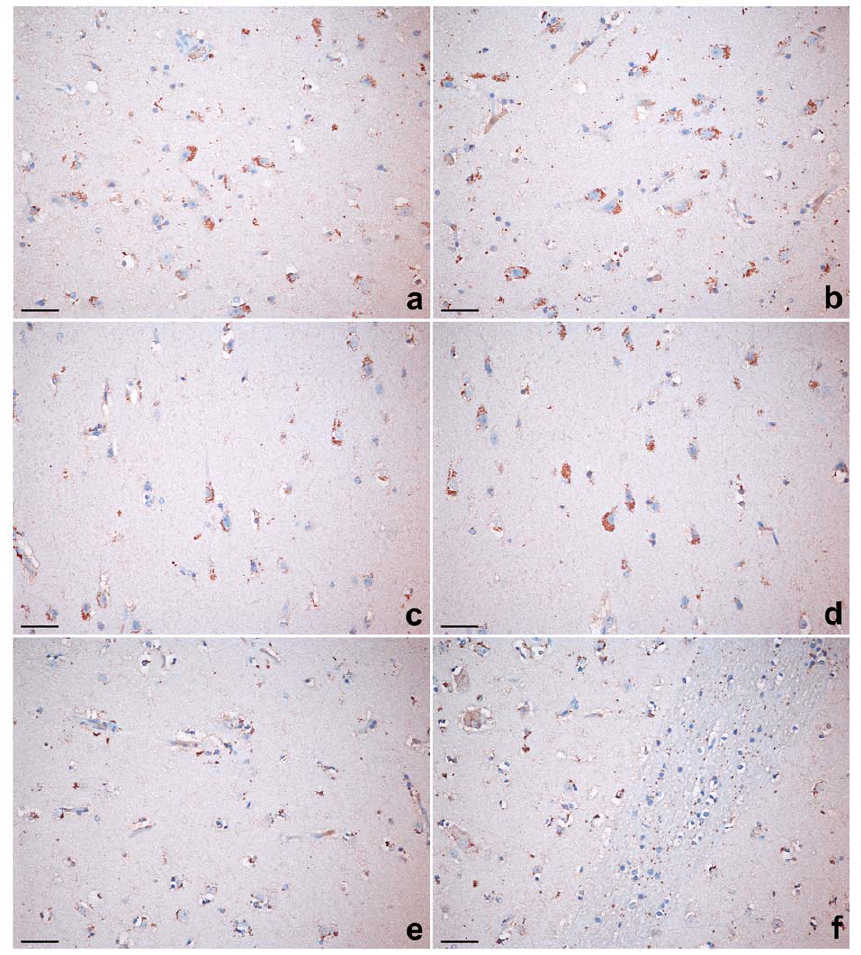
Figure 6. Netrin-G2-ir distribution in the claustrum and adjacent structures. Positive perikarya in the claustrum (a, b) and in the insular cortex (c, d). No immunoreactivity was seen in the putamen (e, f). Scale bars =50 m